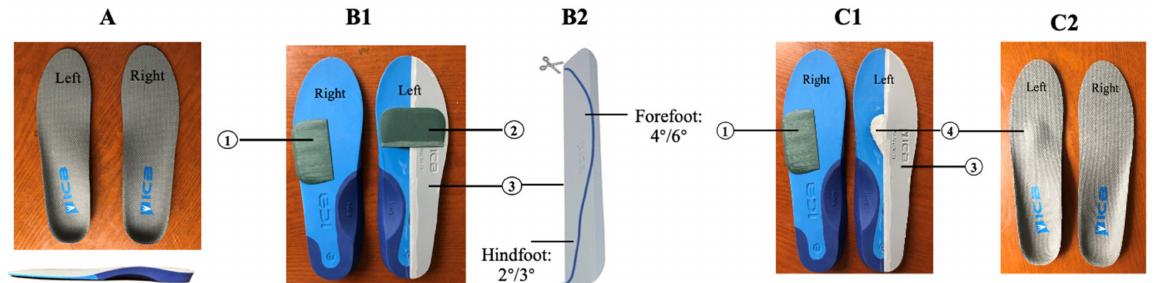
Figure 2. Conventional prescriptions for hemiplegia (left-sided hemiplegia). Note: ( A ) demonstrated a pair of prefabricated insoles with a 5 ◦ lateral wedge and arch support. ( B1 – C2 ) demonstrated two typical prescriptions for hemiplegia: (1) forefoot pad (2 ◦ or 4 ◦ ), which was stuck on the lateral of the unparetic forefoot to increase the stability of the unaffected foot; (2) forefoot pad (2 ◦ or 4 ◦ ), which was stuck on the paretic forefoot in order to promote ankle dorsiflexion; (3) inversion ramp pad (4 ◦ or 6 ◦ ), which was stuck on the lateral of the paretic foot. The whole pad was trimmed along the line to reach forefoot 4 ◦ -hindfoot 2 ◦ or forefoot 6 ◦ -hindfoot 3 ◦ , and its medial edge was polished into a slope to promote the paretic foot’s pronation movement; and (4) metatarsal dome pad, which was stuck slightly posterior to the metatarsal heads in order to alleviate paretic forefoot plantar pressure on the paretic side. All of the above pads were stuck to the plantar surface of the